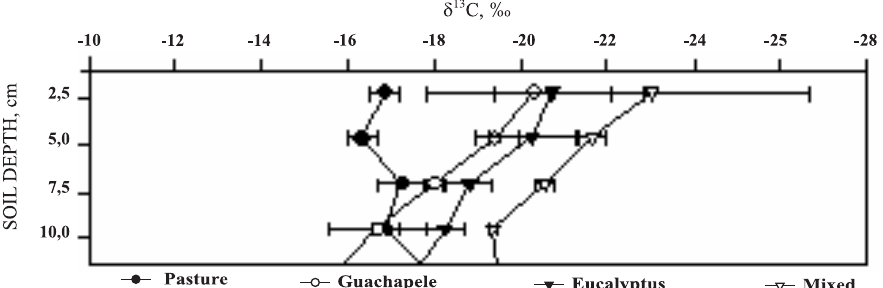
Figure 3. Distribution of natural abundance 13 C in relation to soil depth in different systems. Bars indicate standard errors of the